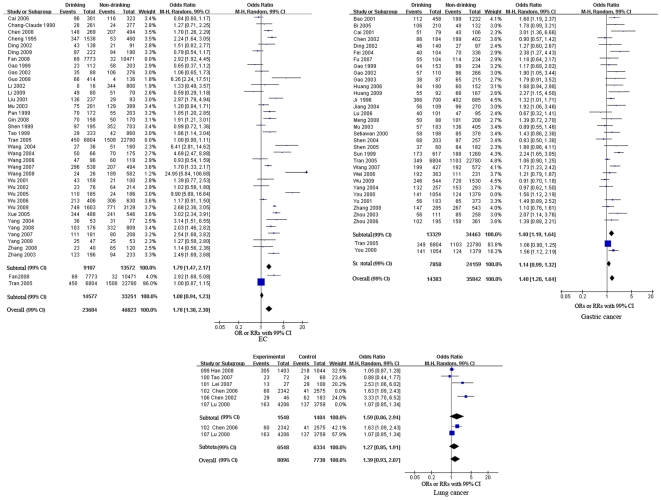
Forest plot of relative risk estimates of incident EC, gastric cancer, and lung cancer by alcohol consumption in Chinese.This figure shows forest plots for the meta-analysis of the association between alcohol consumption and the risk of EC, gastric cancer, and lung cancer. OR and the 99% CI for each cancer was given.